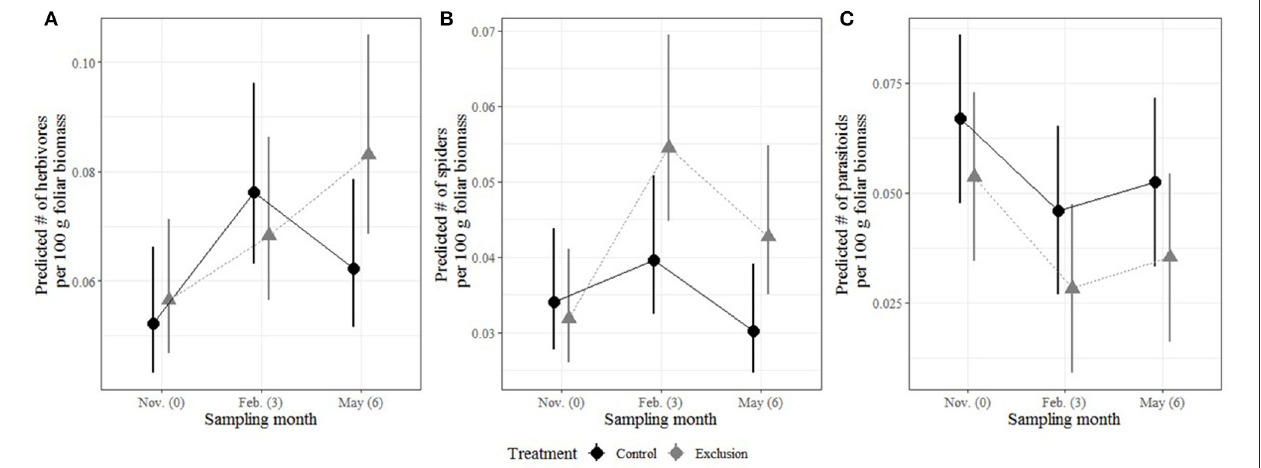
FIGURE 3 | Means and confidence intervals predicted from the GLMM output for herbivores (A) , spiders (B) , and parasitoids (C) per 100g foliar biomass. Black circles represent the control treatment and gray triangles represent the exclosure treatment. Note that the y-axes are different in each